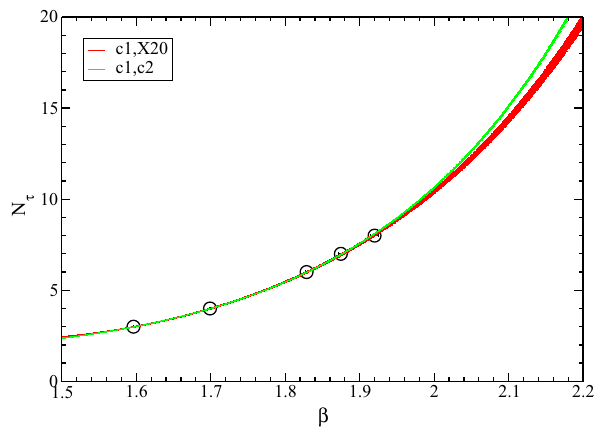
Fig. 1 Interpolation of N τ versus β using “Fit2” and “Fit3” of Table 2